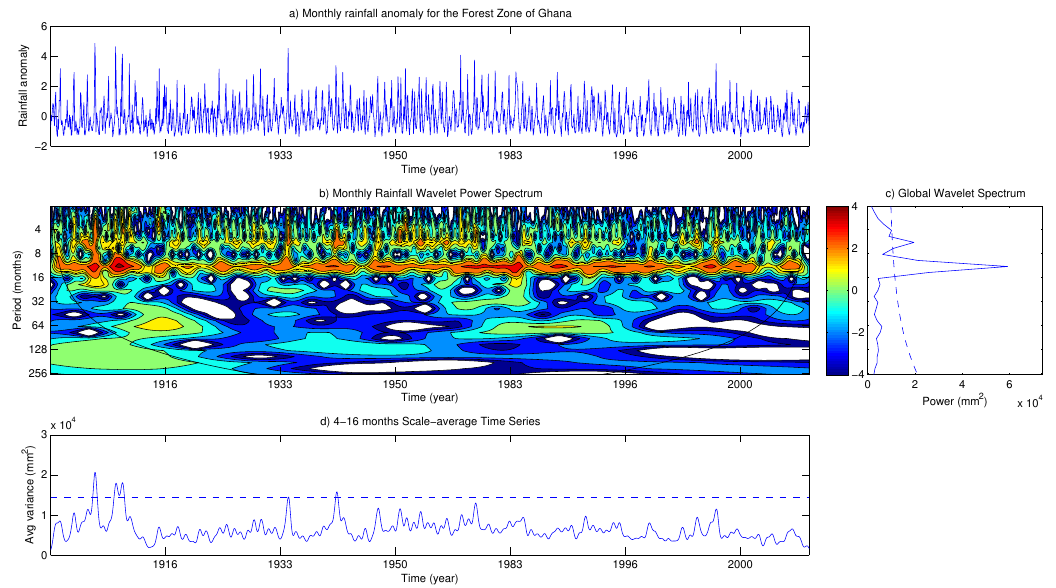
Figure 18. ( a ) Monthly Rainfall Anomaly in the Forest Zone for the 1901–2010 period. ( b ) Wavelet Power Spectrum for the Forest Zone. Cross-hatched region is the cone of influence. ( c ) The global wavelet power spectrum. The dashed line is the 5% significance level for the global wavelet spectrum; and ( d ) Scale-average wavelet power over the 4–16 months band. The dashed line is the 95%